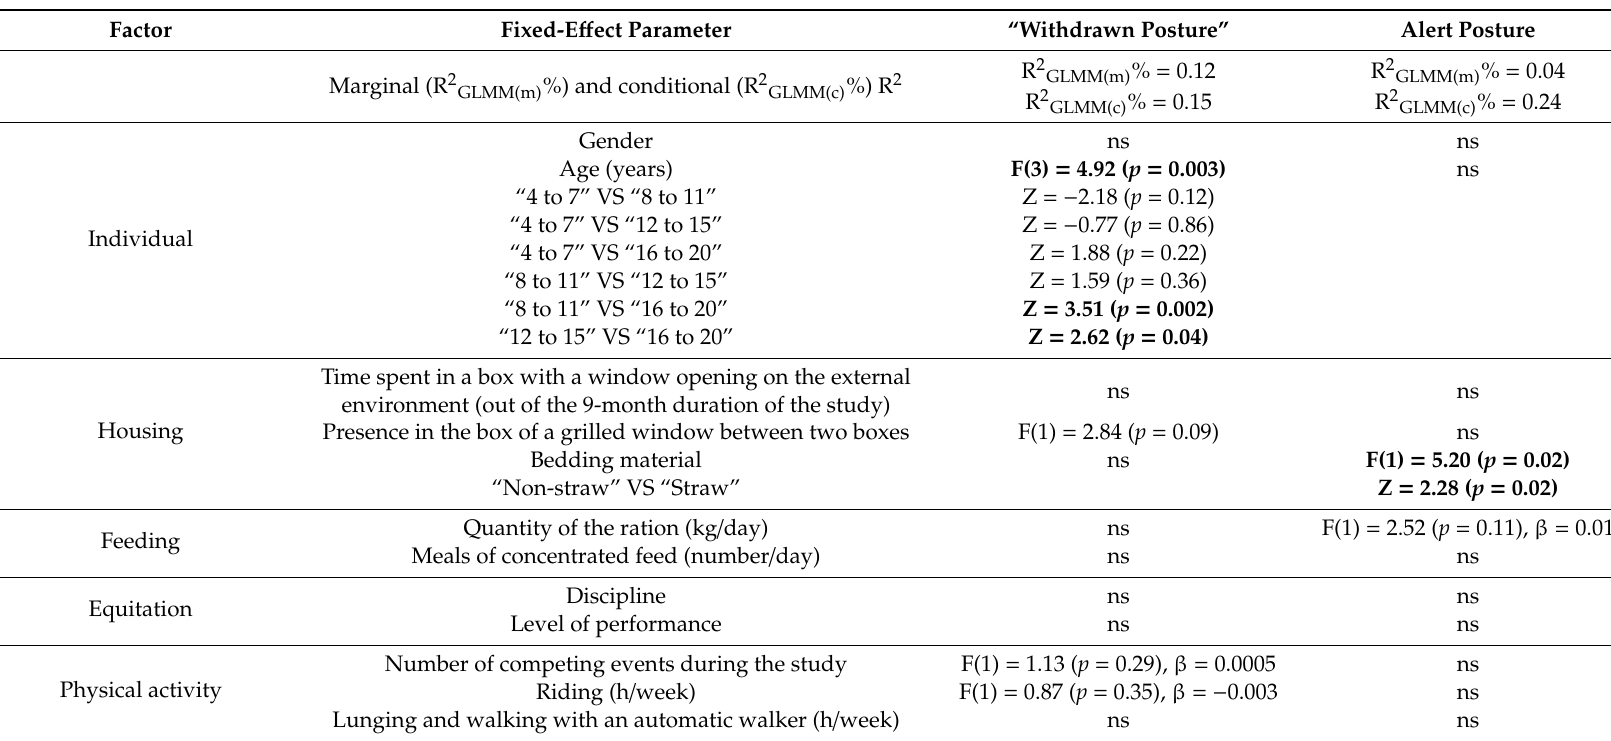
Table 5. Fixed-e ff ect parameters kept to build final models of “withdrawn” and alert postures after univariate analysis (linear-mixed e ff ects models (LMMs) fitted with restricted maximum likelihood (REML) and Satterthwaite approximation). Marginal and conditional R 2 quantify the proportion of variance explained by the fixed factors (R 2 GLMM(m)% ) and both the fixed and random factors (R 2 GLMM(c) %). Gender and age were controlled for as confounding factors. The results of F-tests and Tukey post-hoc tests (Z values) are presented along with p -values ( p ). Values in bold represent significant parameters with level accepted at p ≤ 0.05. ns: